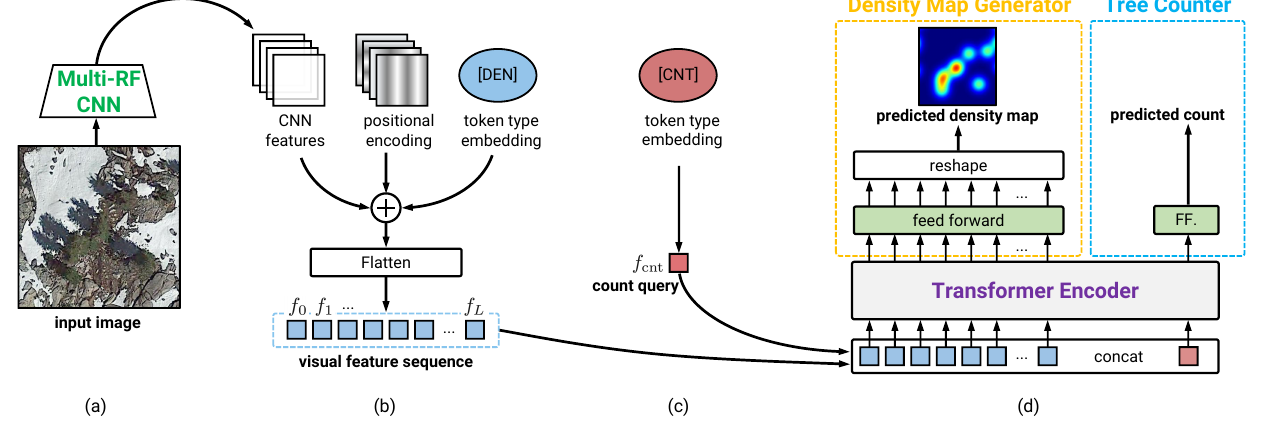
Figure 2. The architecture of the proposed DENT Network. ( a ) Visual features are extracted using a Multi-Receptive Field convolutional network (Multi-RF CNN). ( b ) Positional encoding and token type embedding are applied to the visual features. The visual features are flattened as a sequence [ f ] . ( c ) f cnt , the embedding of CNT token, works as a count query. ( d ) The visual feature 0 , f 1 ,..., f L sequence and the count query are concatenated as the input of the transformer encoder. On top of the transformer encoder, there are two heads: A Density Map Generator (DMG) predicts the density of objects at different positions. A counter predicts the count of the objects in the whole input